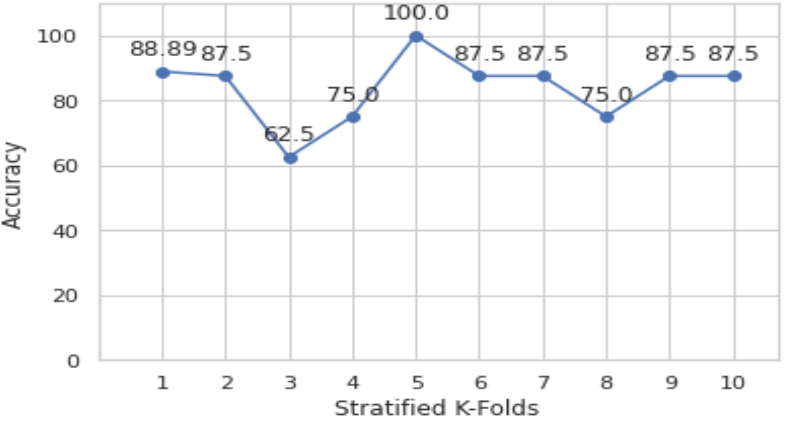
Figure 7. The classification accuracies of the RF model using the stratified ten-fold cross-validation. The classification accuracy of the SVM model using stratified five-fold cross-validation is shown in Figure 8. It demonstrates fold-3 (cid:48) s superior accuracy. The stratified 5-fold cross- validation was supported by this model, which had a mean accuracy of 85.22% and an SD of 0.0839. Kernel = rbf, Gamma = 0.1, and C = 3 were chosen as the optimal parameters following Hyperparameter tuning using stratified 5-fold cross-validation.